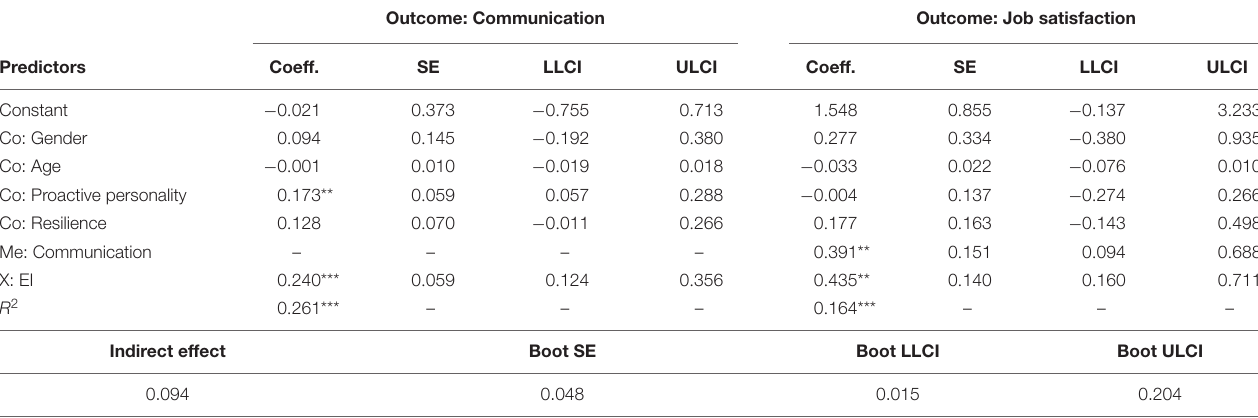
TABLE 3 | Summary of mediation